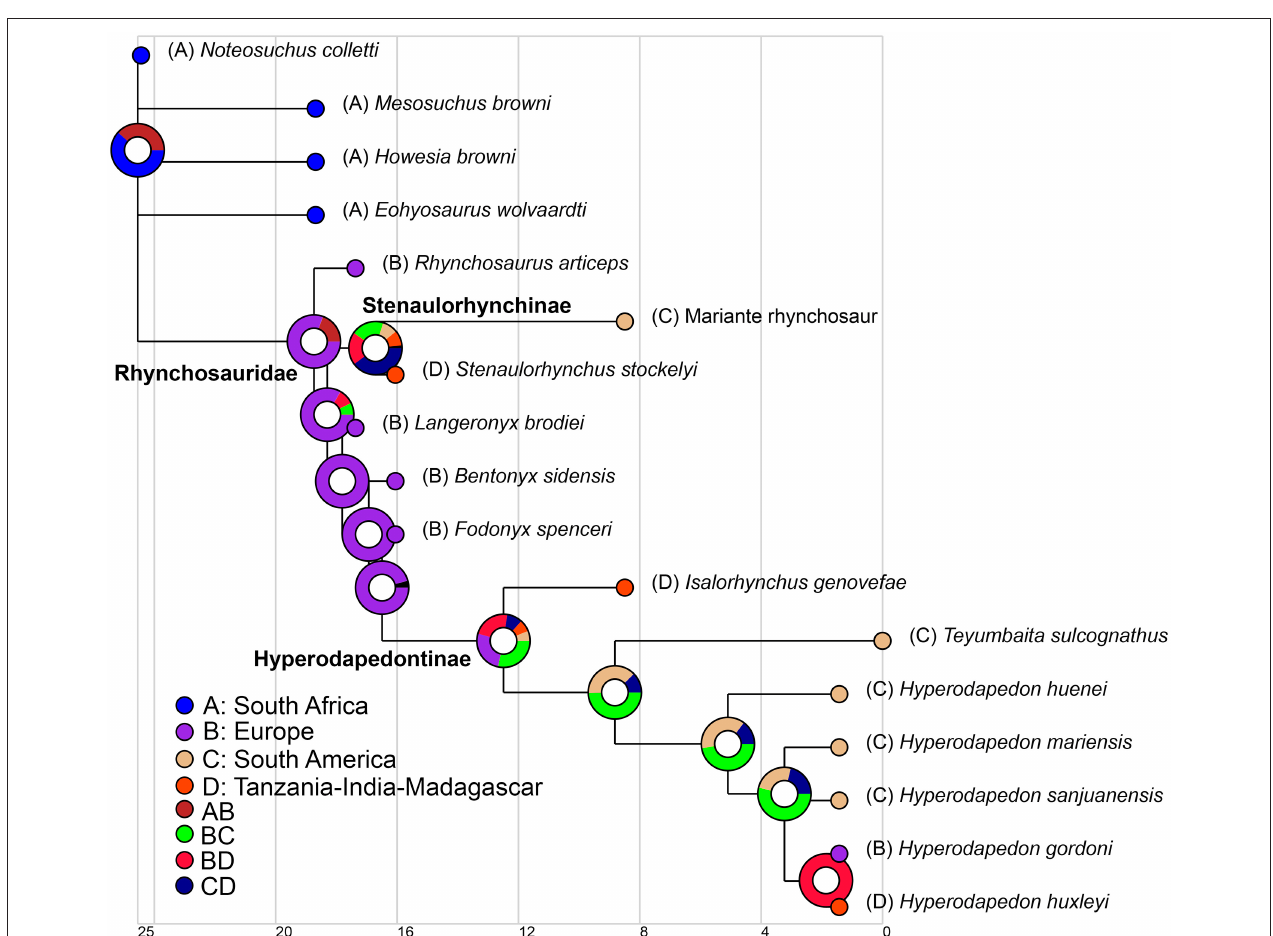
FIGURE 11 | Paleobiogeographic analysis of rhynchosaurs based on a global phylogeny of the group. Results obtained from DEC (Dispersion-Extinction-Cladogenesis) analysis. The temporal scale at the bottom is in millions of